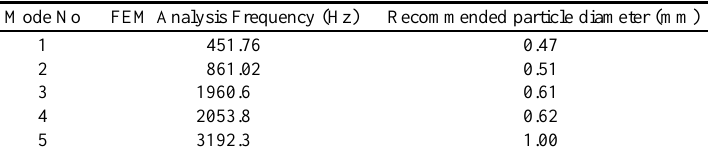
Fig. 24. Acceleration response of a measurement point under bonding process. Table 7 Recommended particle diameters for the bond